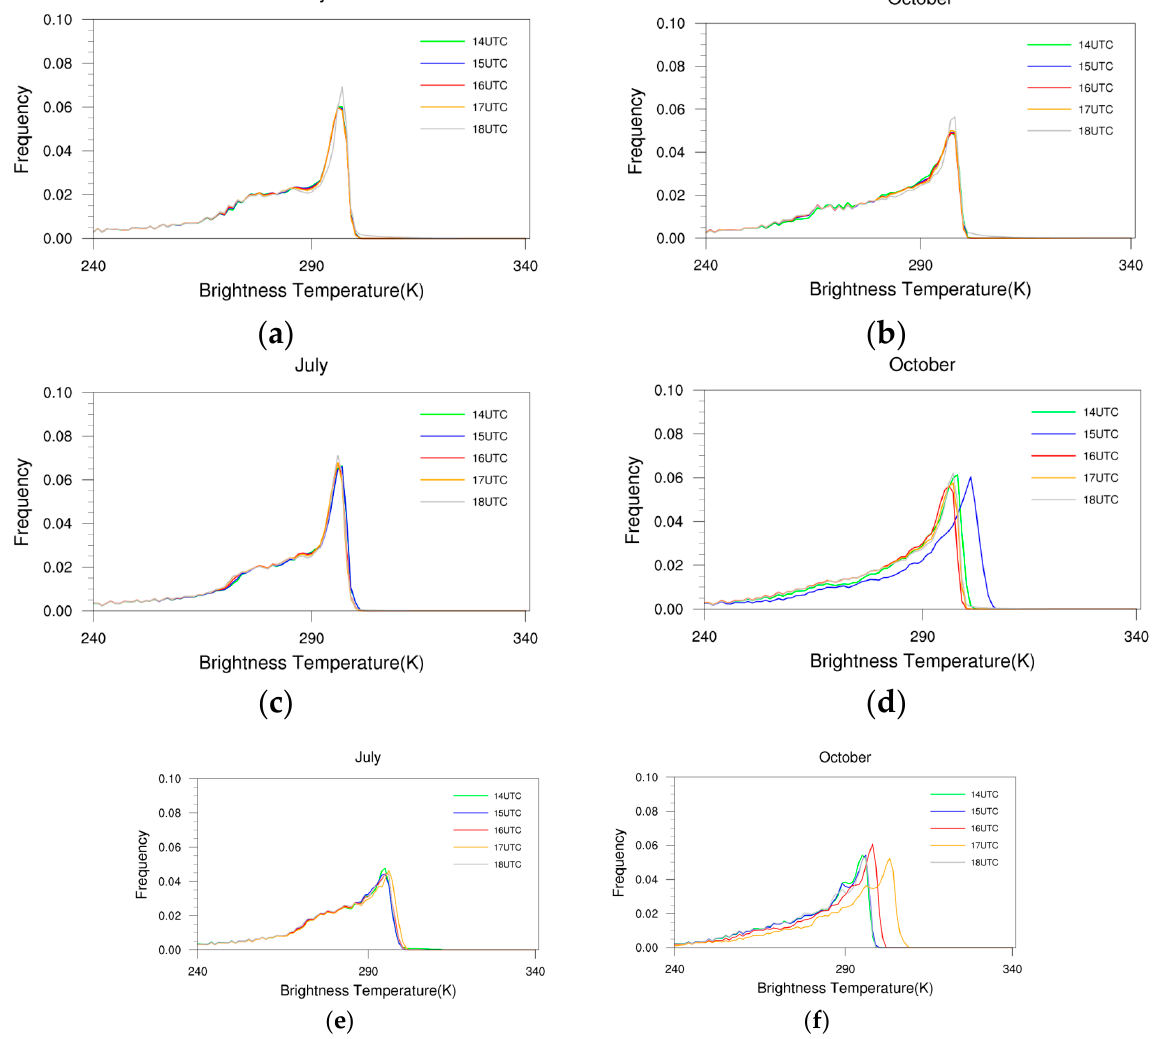
Figure 6. Frequency distribution of ~3.75 μ m brightness temperature with satellite zenith angles less than 60° for ( a , b ) Himawari-8/AHI, ( c , d ) Fengyun-4B/AGRI and ( e , f ) Fengyun-4A/AGRI at 1400, 1500, 1600, 1700 and 1800 UTC in ( a , c , e ) from 26 July to 31 July and ( b , d , f ) from 26 October to 31 October 2022.